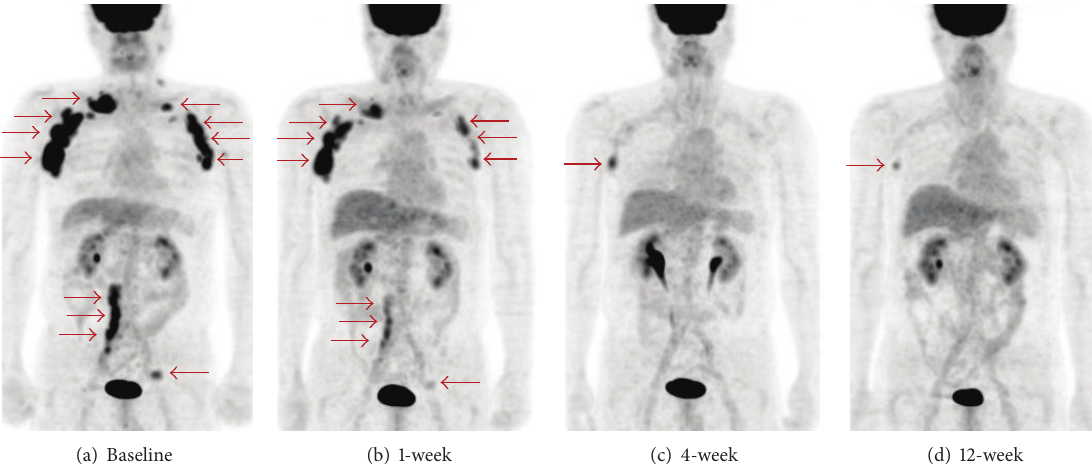
Figure 4: Maximum intensity projection images of patient 3. (a) Baseline, (b) 1-week scan, (c) 4-week scan, and (d) 12-week scan. FDG-avid lesions (arrow) are seen in bilateral subclavicular, axillary, abdominal para-aortic, and left inguinal area at baseline. Decrease in metabolism is observed at 1 week. All lesions continued to decrease to 12 weeks. At 12 weeks, only slight accumulation in the right axillary lesion is visible. Physiological activities are seen in the liver and the urinary tract.